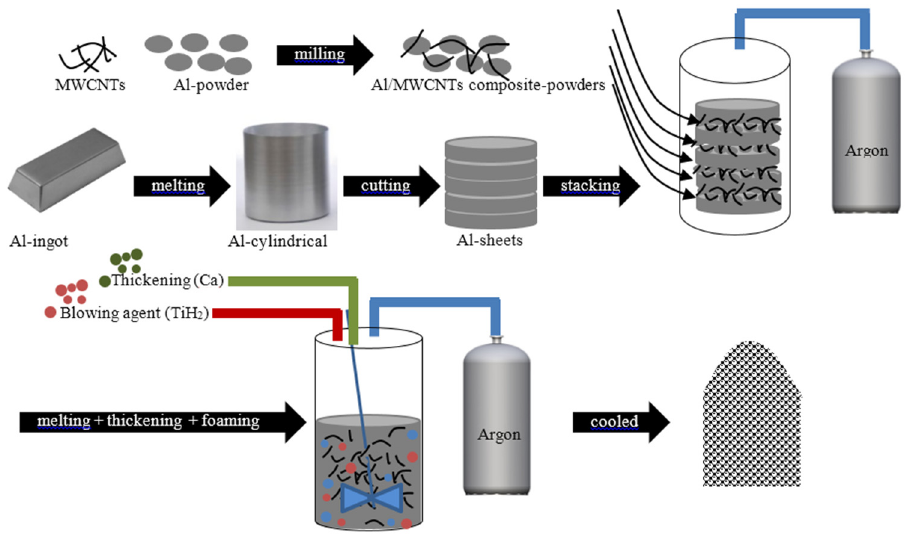
Figure 11. Schematics of the fabrication process of closed ‐ cell Al ‐ foams with and without MWCNTs [140].